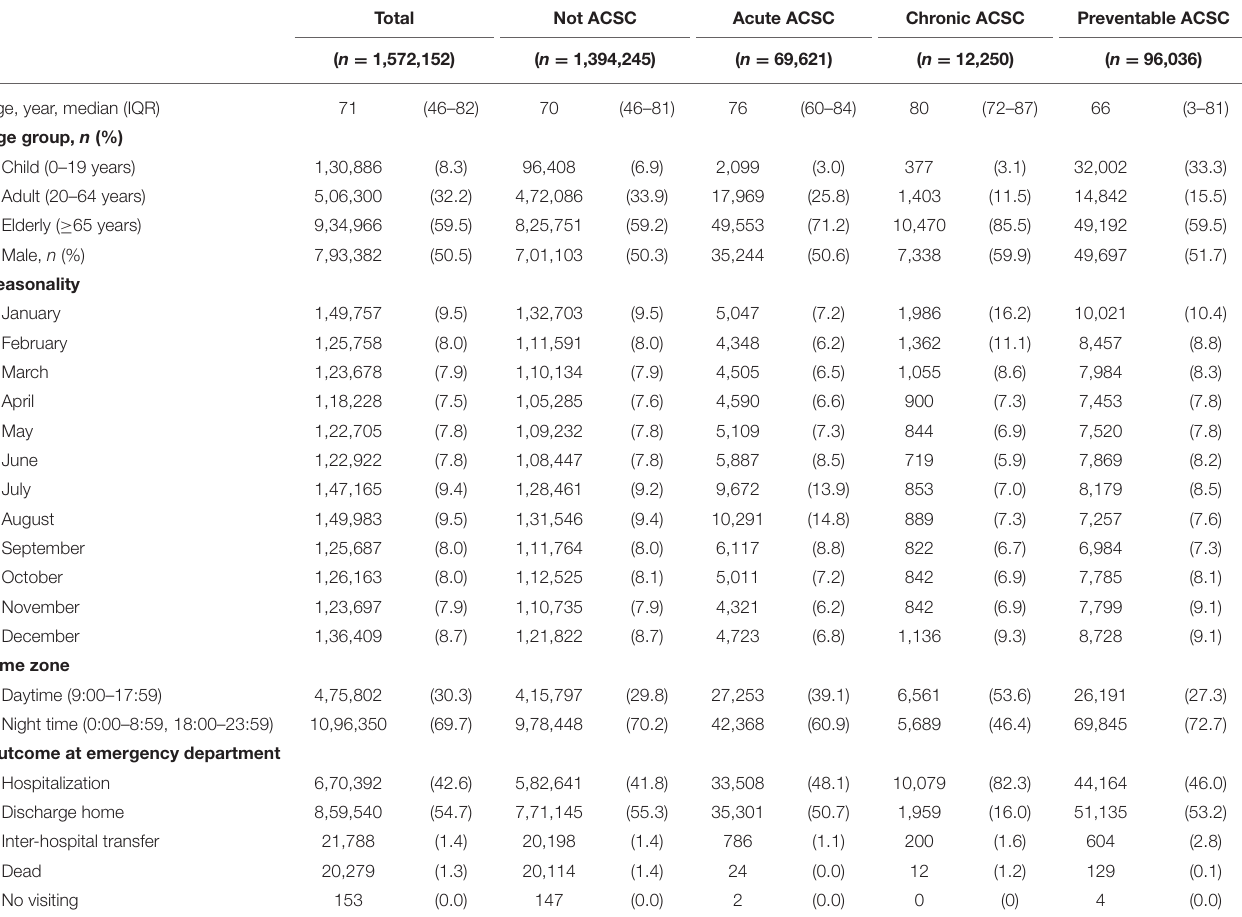
TABLE 1 | Patient characteristics among all cohorts and the propensity score-matched